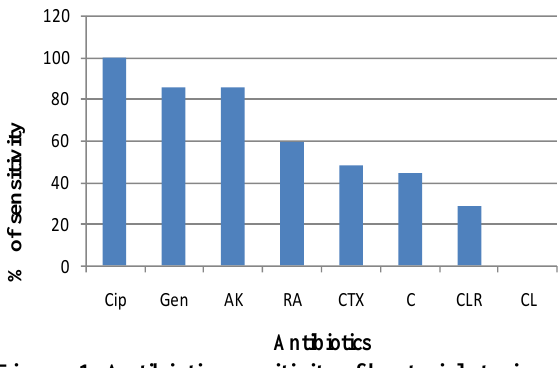
Figure, 1: Antibiotics sensitivity of bacterial strains which isolated from eggs Cip: Ciprofloxacin Gen: Gentamicin AK: Amikacin RA: Rifampin CTX: Cefotaxime C: Chloramphenicol CLR: Clarithromycin